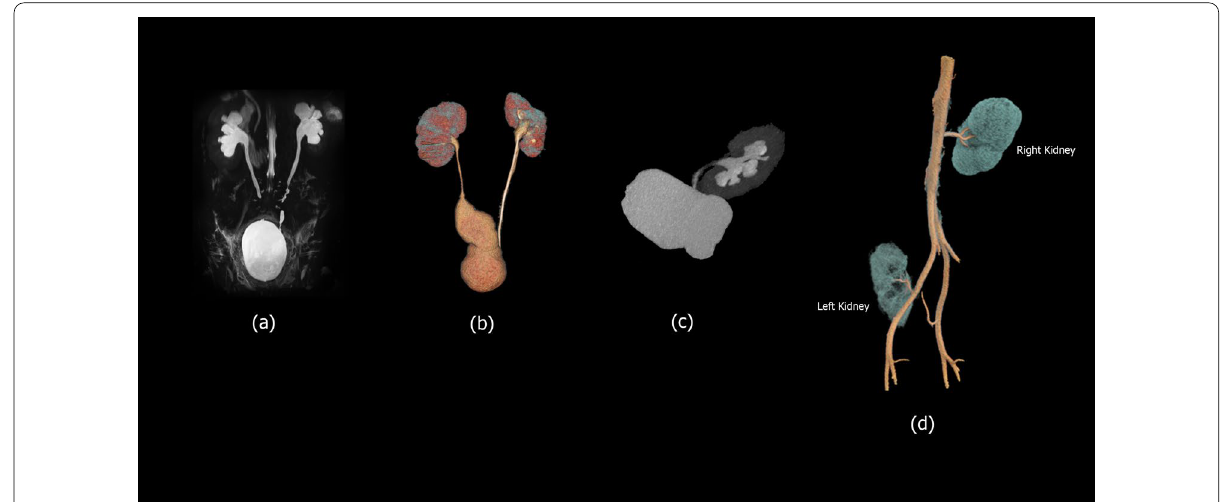
Fig. 1 a MRI showing bilateral hydroureteronephrosis with clubbed calyces. b CT showing unobstructed drainage in right renal unit. c CT showing unobstructed drainage in left autotransplanted renal unit. d CT images showing bilateral renal vascular tree after reconstructive procedures